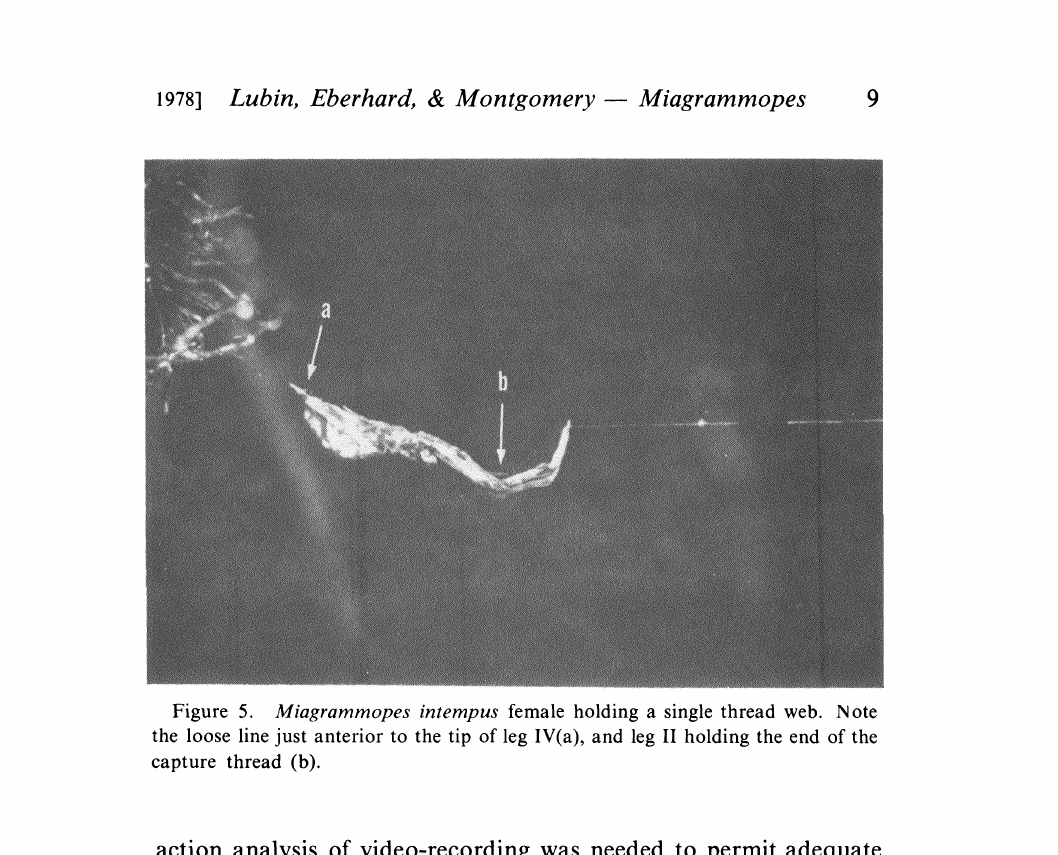
Figure 5. Miagrammopes intempus female holding a single thread web. Note the loose line just anterior to the tip of leg IV(a), and leg II holding the end of the capture thread